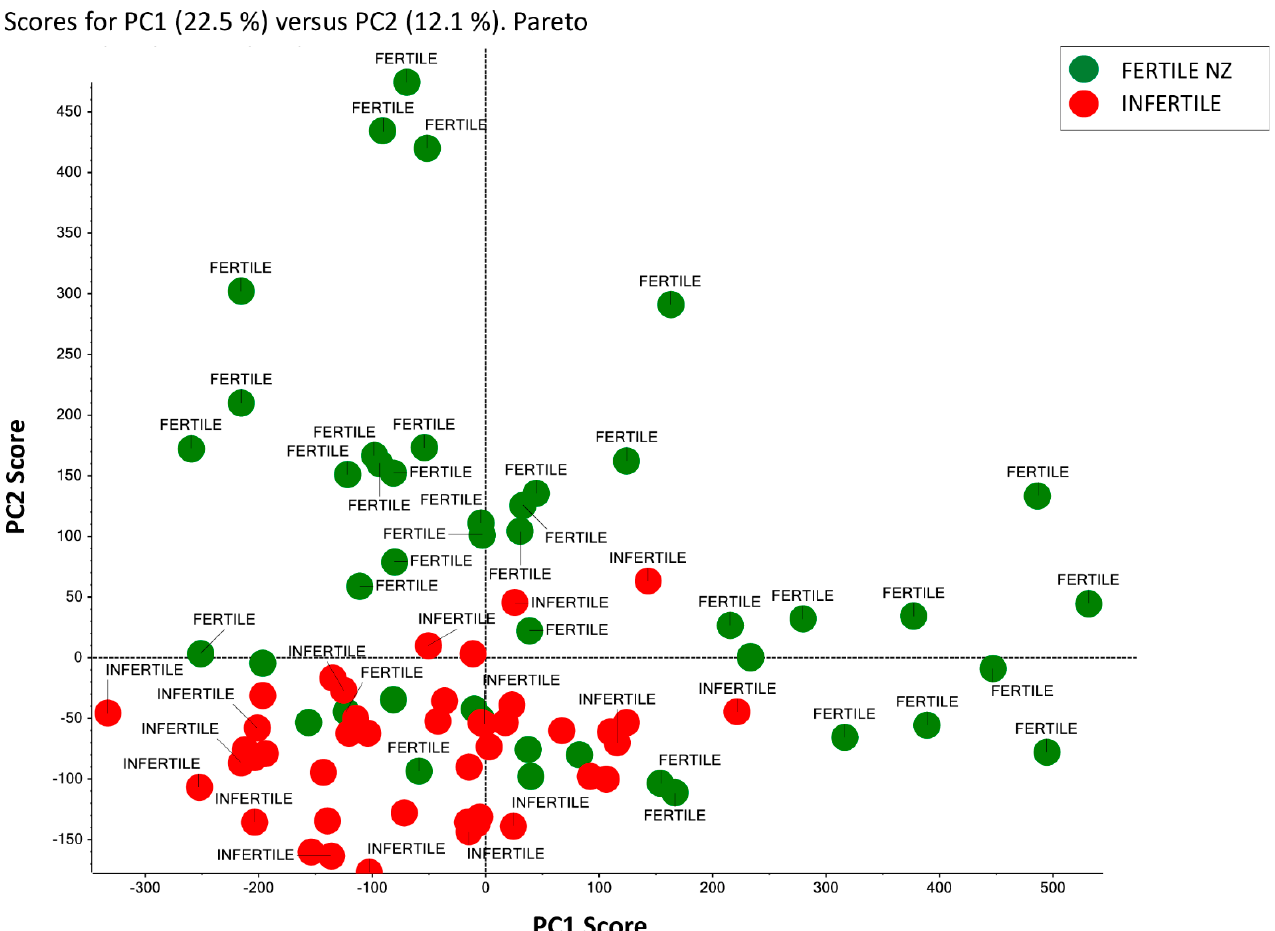
Figure 4. Unsupervised PCA of SP from fertile and infertile men enrolled in this study. Unsupervised PCA scores plot acquired by MarkerView™ software represents SP clustering of fertile (green dots) vs. infertile men (red dots). Pareto scaling was applied on the MALDI-MS data set. Table 2. Discriminant peaks significantly different between fertile (n. 15) and infertile (n. 15) men.